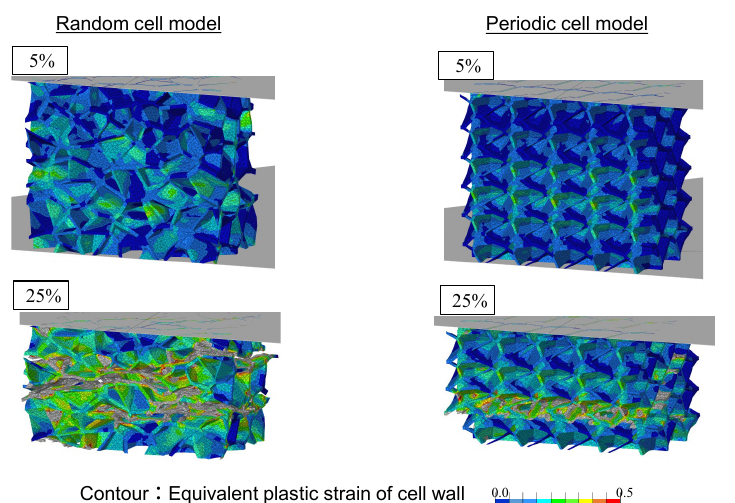
Fig.4. Stress–strain relationships of random and periodic cell models.